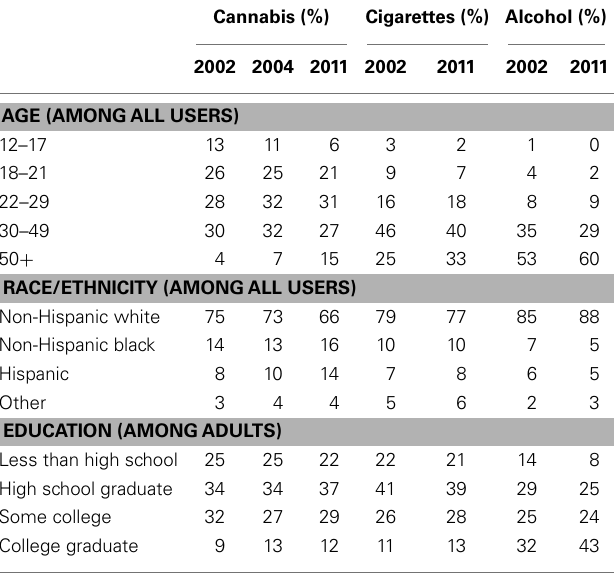
Table 3 | Change in demographic profiles of daily/near-daily users of cannabis, cigarettes, and alcohol,